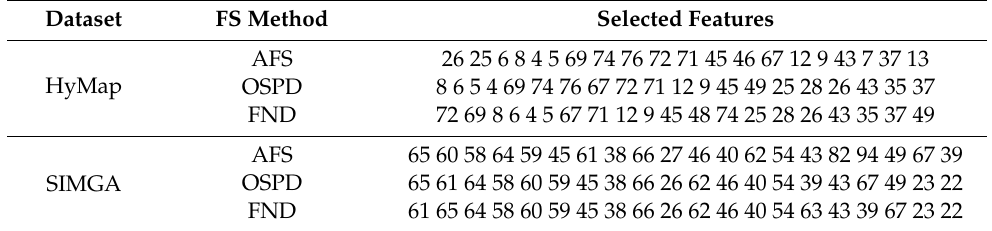
Table 5. The first twenty optimal features selected by the proposed methods for the first